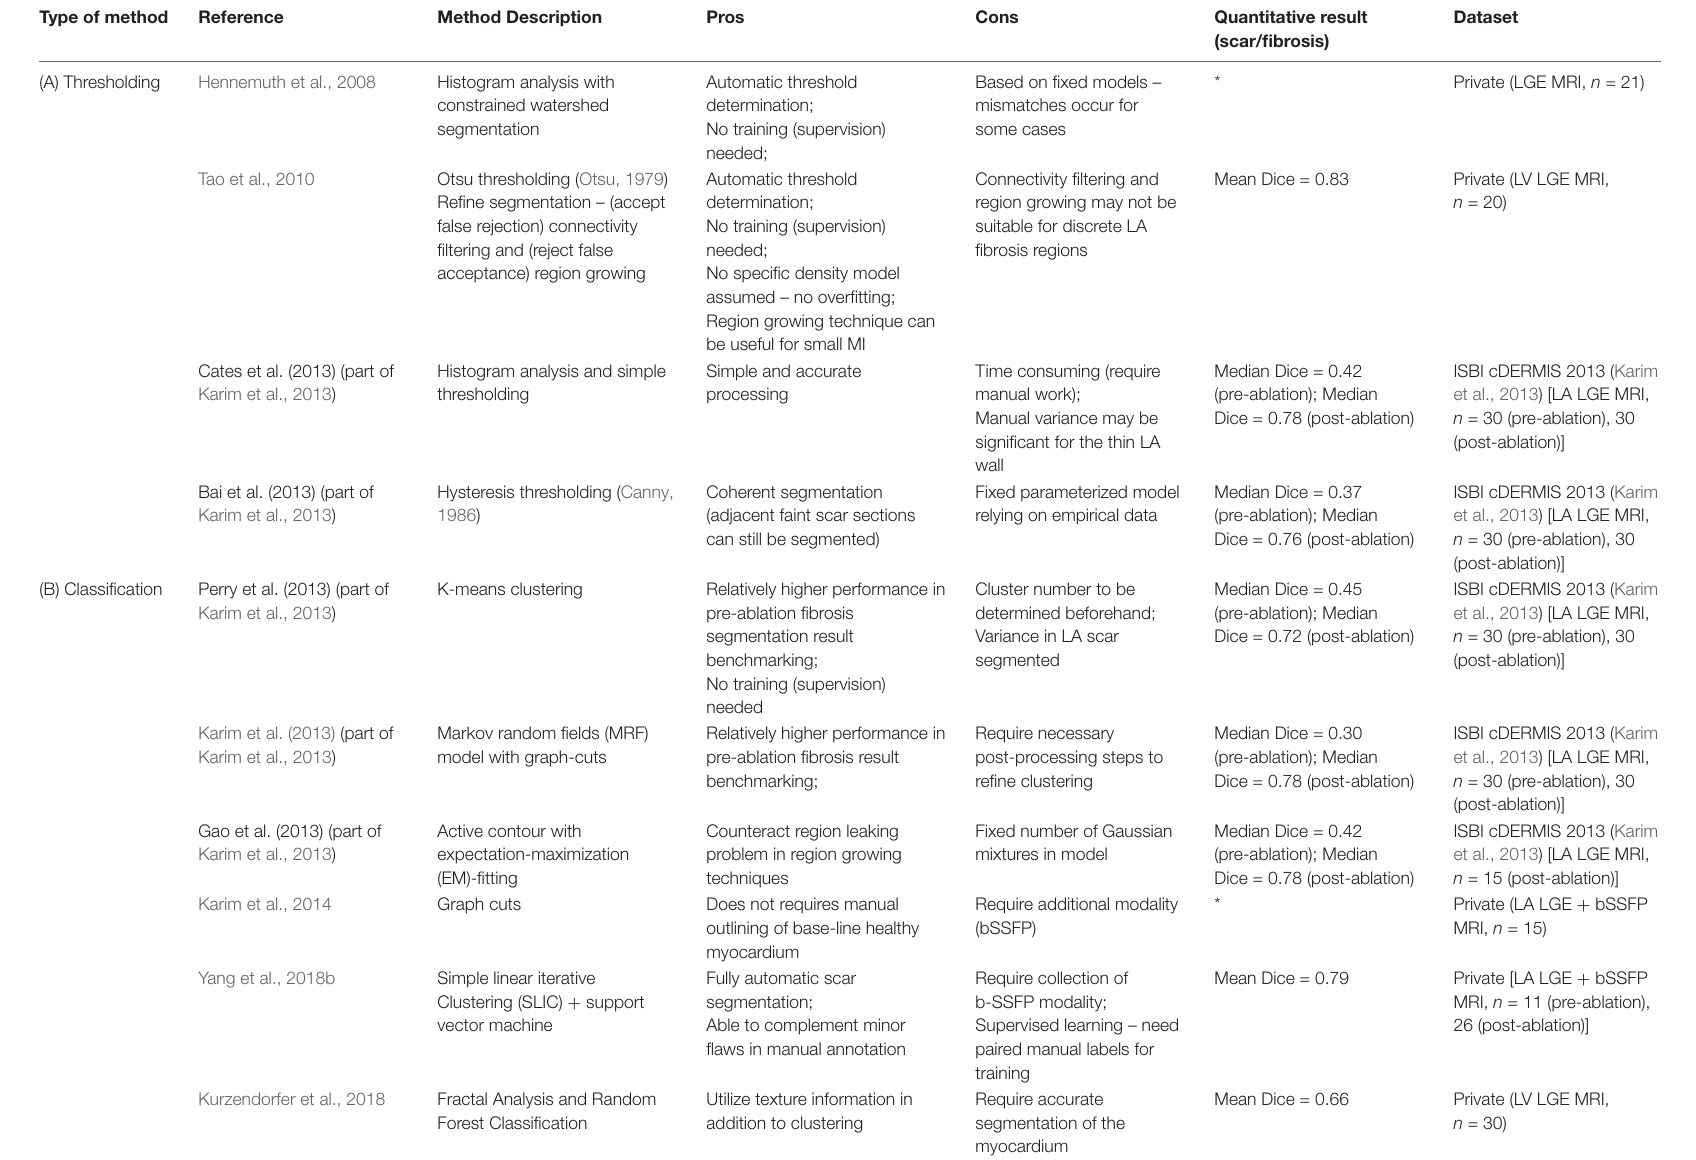
TABLE 3 | Summary of representative conventional methodologies for segmentation of cardiac scar and fibrosis regions on